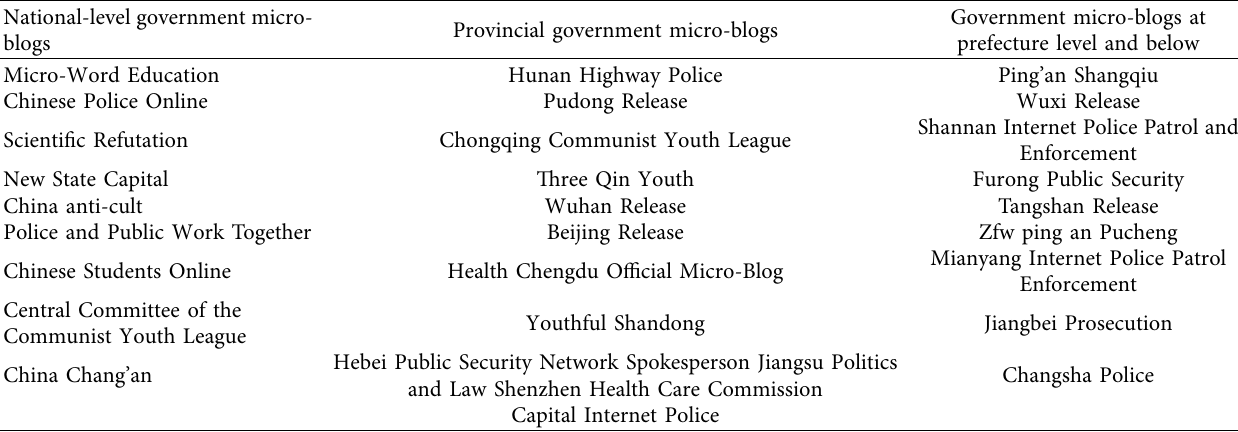
Figure 1: Theoretical framework model. Table 1: Thirty selected government micro-blogs of different